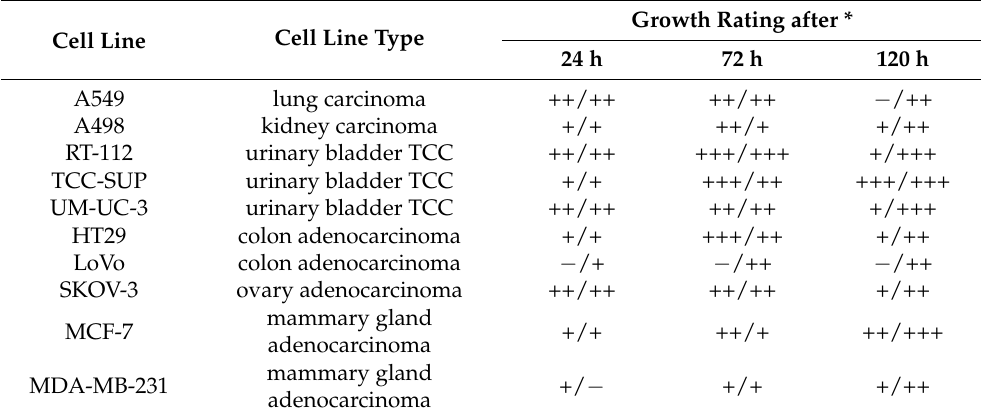
Table 5. Characteristics of cancer cell growth (proliferation) on the LOC platform utilizing CO 2 - independent